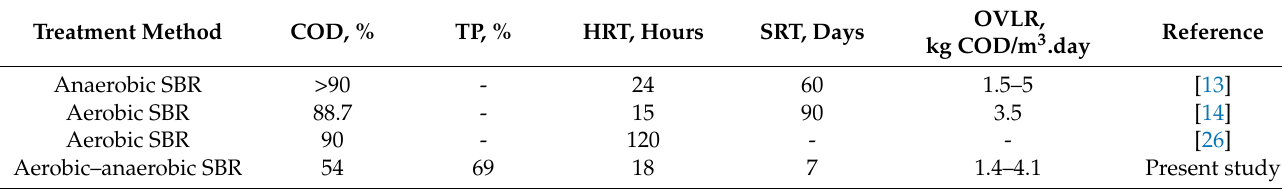
Table 2. Summary of studies on brewery wastewater treatment using a SBR